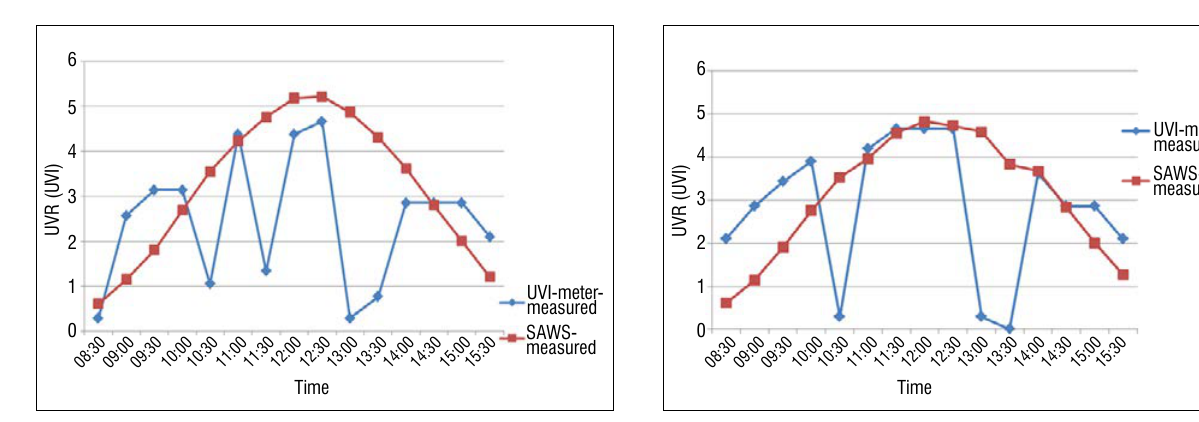
Figure 2: Solar ultraviolet radiation (UVR) on Day 2 measured as an ultraviolet index (UVI) by a handheld device on site and a biometer at the South African Weather Service